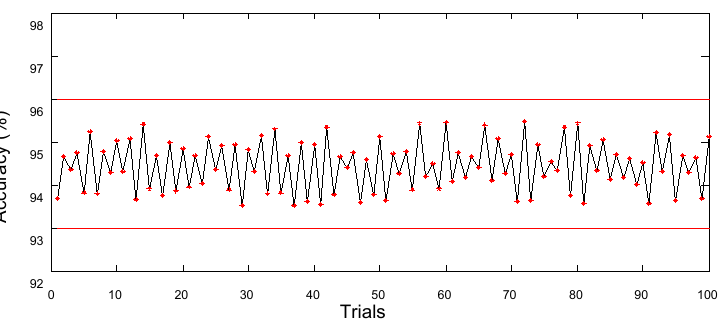
Figure 12. The results of 100 trials.